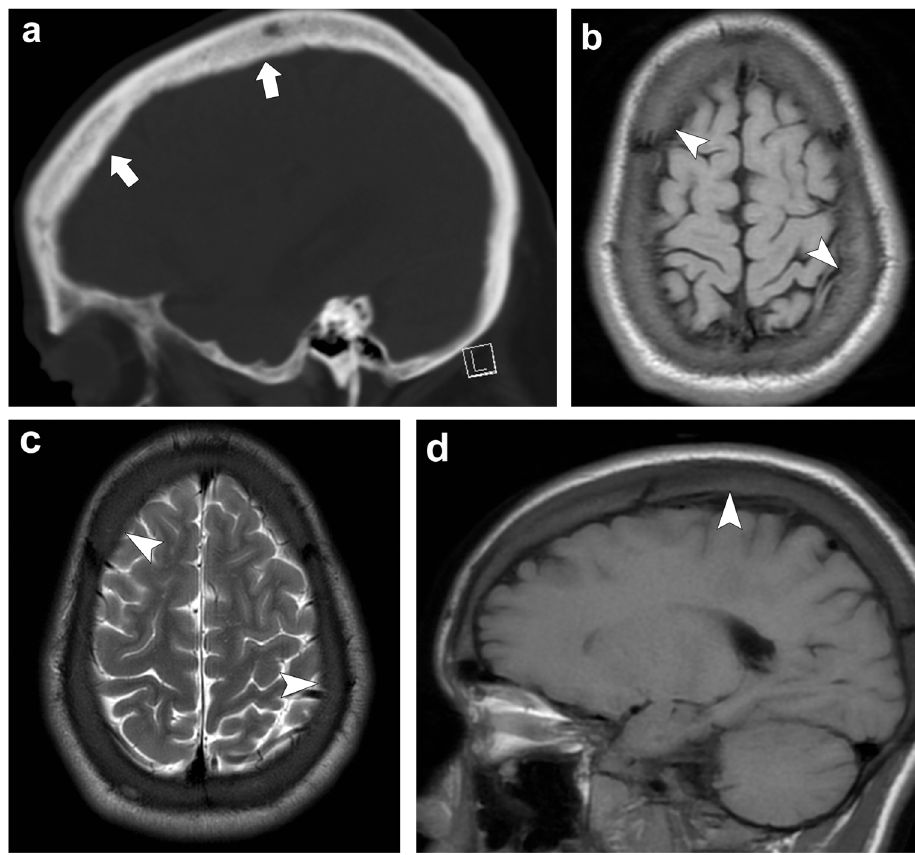
Fig.21 Chronicanaemia. Sagittal head CT ( a ) depicts widening of the diploic space ( thick arrows ). Axial T1-weighted ( b ), axial T2- weighted ( c ) and sagittal T1- weighted ( d ) images portray widening of the diploic space with generalised T1 and T2 marrow hypointensity ( arrowheads ) consistent with red marrow hyperplasia in this patient with sickle-cell